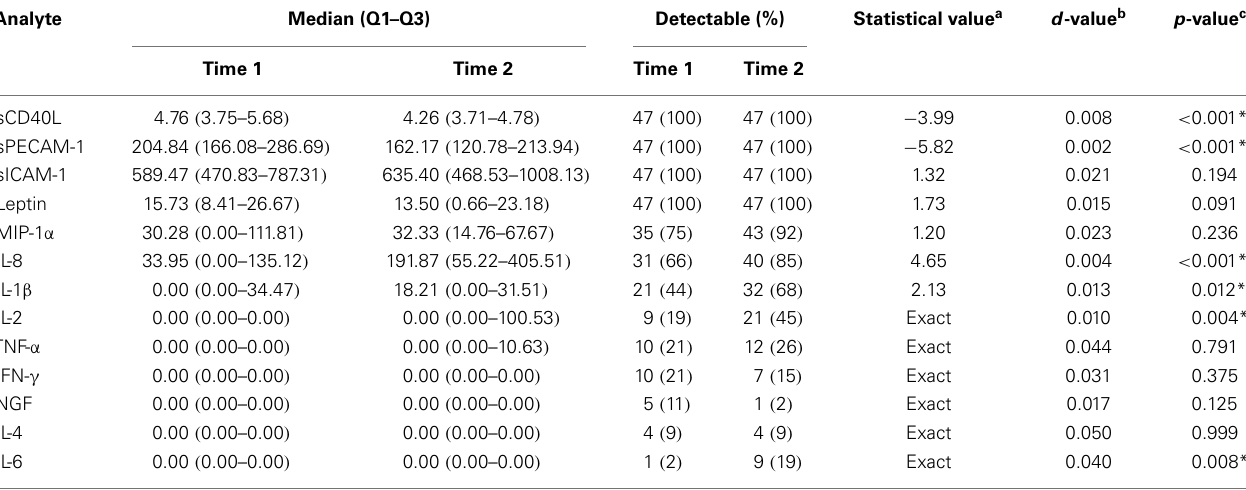
Table 4 | Comparison of multiplex assay analytes in PTSD patients ( n = 47) between two assessments .